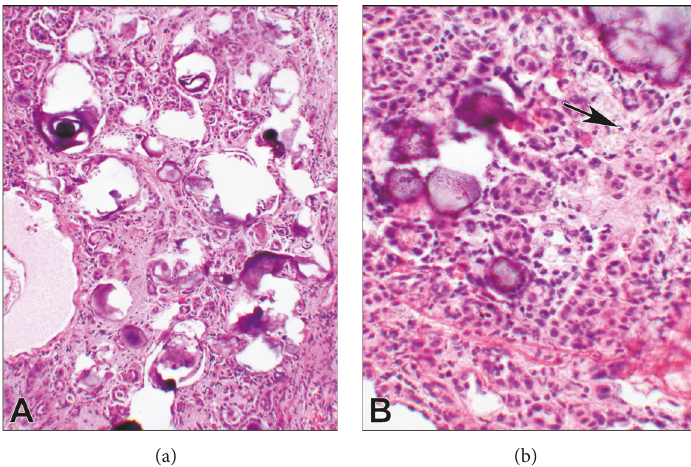
Figure 1: Photomicrographs of the frozen section . ((a), 10x objective) A low magnification of the lesion showing numerous psammoma bodies packed with the tubular nests.((b), 20x objective) At a larger magnification,the psammoma bodies as well as the cellular morphologies are display with more details. Clusters of rather large cells with abundant foamy cytoplasm and eccentric nuclei were also present (arrow).